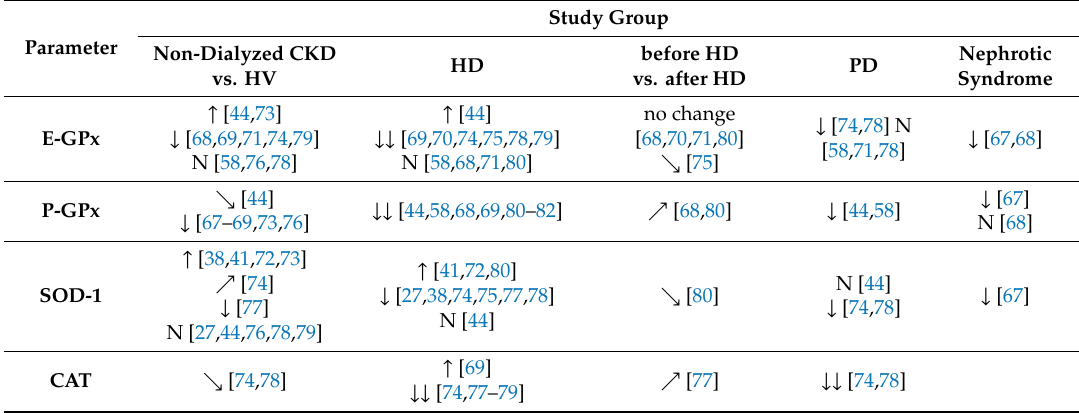
Table 1. The changes in the antioxidative system in chronic kidney disease (CKD), with particular emphasis on glutathione peroxidase (GPx), superoxide dismutase (SOD), and catalase (CAT). HD: hemodialysis, PD: peritoneal dialysis, HV: healthy